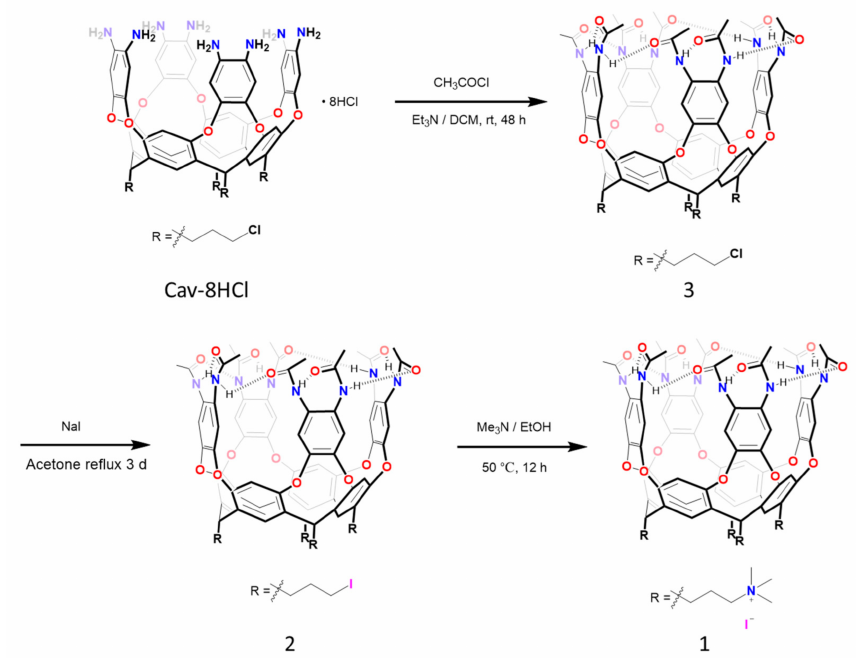
Scheme 1. Route for the synthesis of water-soluble cavitand